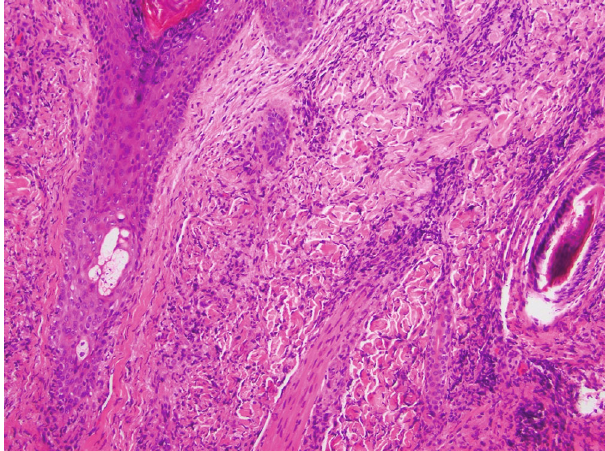
Figure 4: A close up of a di ff erent fi eld shows a predominance of spindled cells with prominent extracellular collagen deposition.